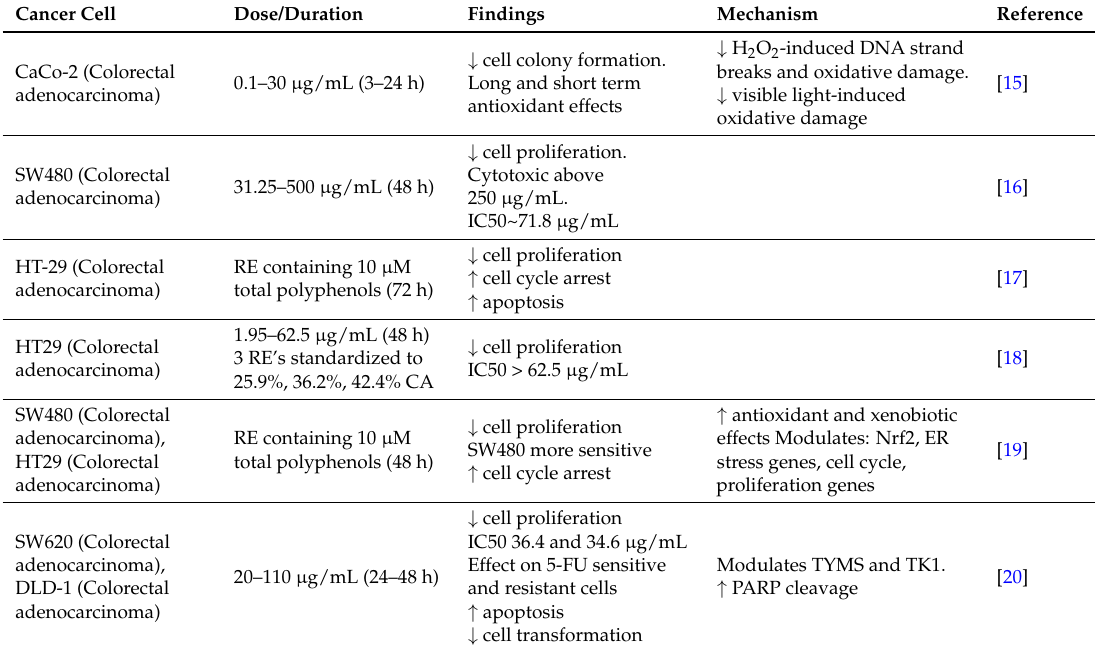
Table 1. Anticancer effects of Rosemary Extract (RE). In vitro studies: colon cancer. Cancer